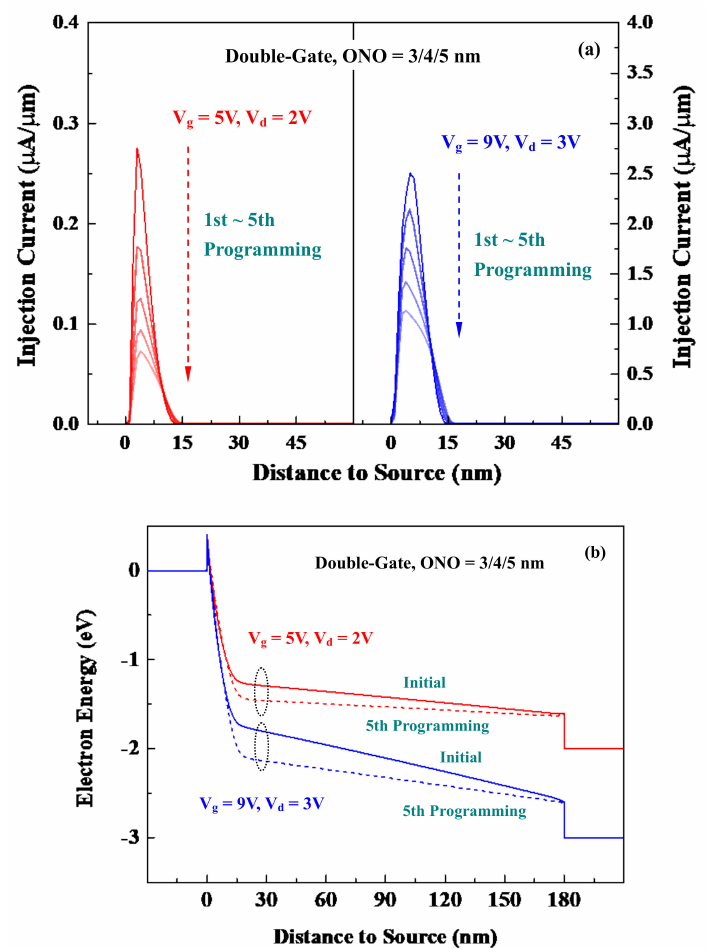
Figure 14. ( a ) Iterative results of spatial distributions of injection currents in two Schottky barrier cells. Two di ff erent scales adopted in the vertical axis. ( b ) Conduction band diagrams of programmed cells along the channel surface at the initial and 5th programming